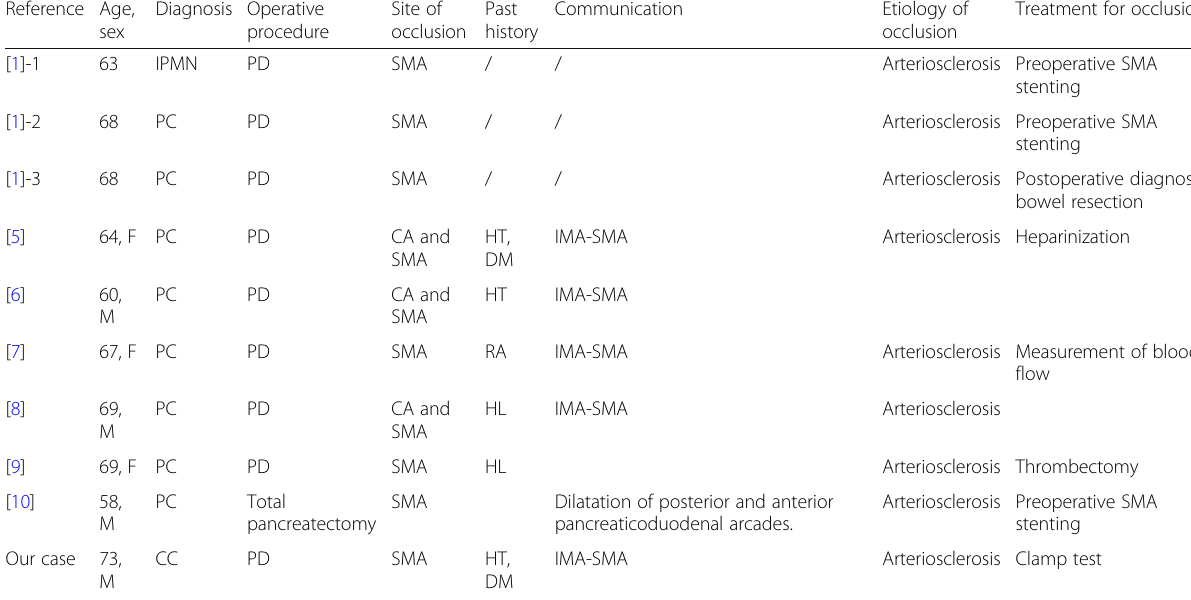
Table 1 Ten cases of patients with benign SMA occlusion who have undergone PD or total pancreatectomy Reference Age,